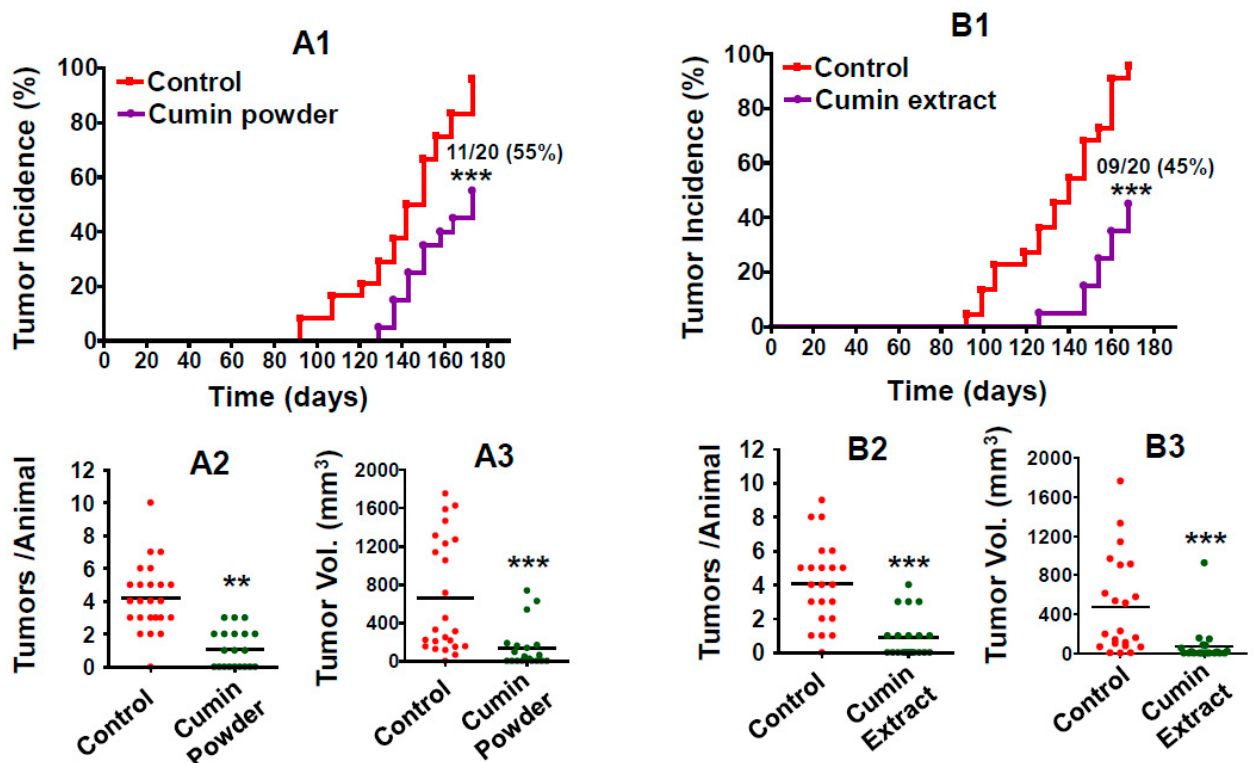
Figure 2. Effects of diet supplemented with cumin powder (7.5%, w / w ) ( A ) and dried ethanolic cumin extract (1%, w / w ) ( B ) on the following various mammary tumorigenesis indices: tumor incidence and latency ( A1 , B1 ), tumor multiplicity ( A2 , B2 ), and tumor volume ( A3 , B3 ). After acclimatization, ACI rats were subcutaneously grafted with 9 mg E2-containing silastic implants. Animals were palpated starting from week 12 and tumor incidence was recorded weekly and analyzed using a non-parametric log-rank test. Numbers denote the animals without tumor at the end of the study. Tumor multiplicity and tumor volumes were calculated at the time of euthanasia and analyzed using unpaired two-tailed Student’s t -test. Asterisk indicates significant difference between control diet versus cumin diet-fed animals. ** p < 0.01; *** p < 0.001.